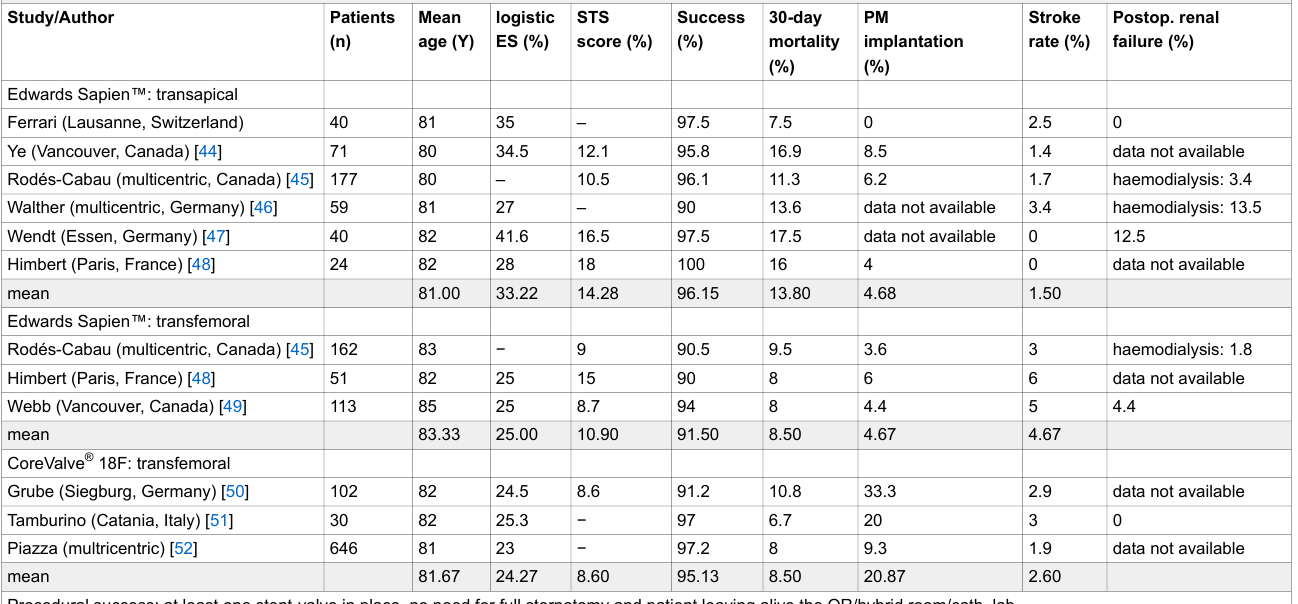
Table 1 Comparison between the most recently published series of transapical and transfemoral transcatheter aortic valve implantations using the Edwards Sapien™ THV and the Medtronic CoreValve ®